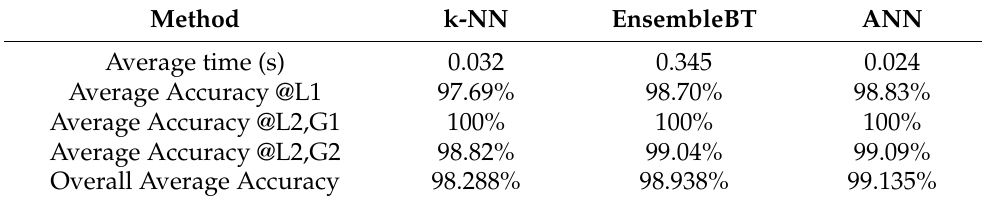
Table 2. Comparative summary of classification algorithms using the Malimg